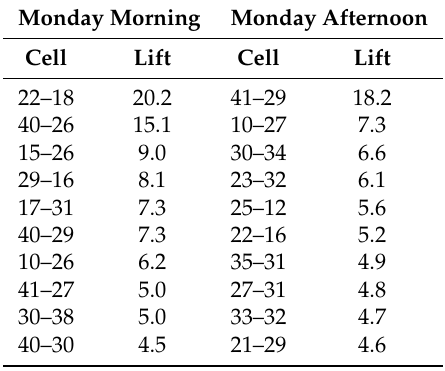
Table 7. Examples of associations used to build the dynamic neighborhoods for cell catering